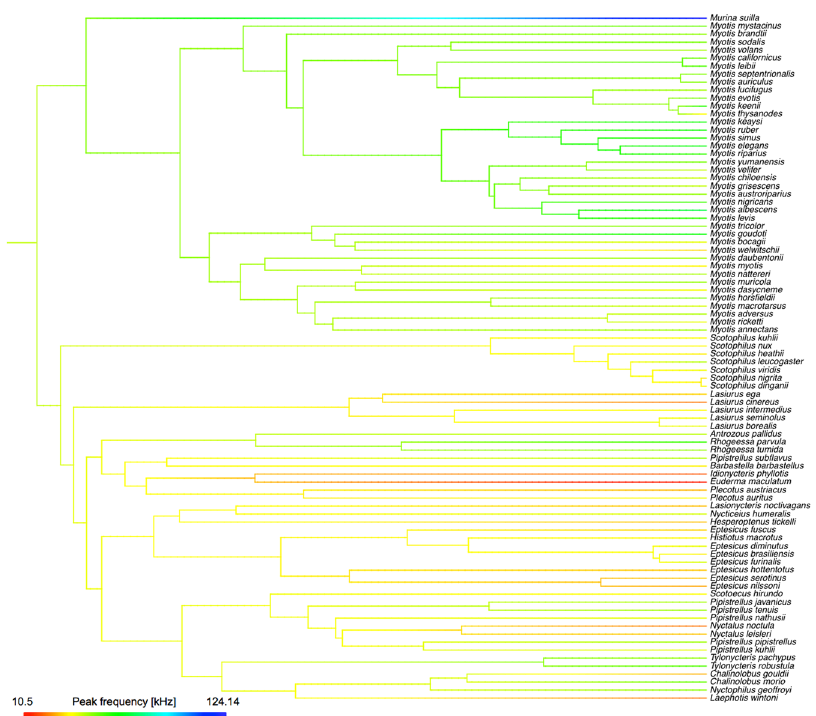
Figure 4. A phylogeny (Shi and Rabosky) 41 showing peak frequency (kHz) mapped along the branches of the tree using Maximum